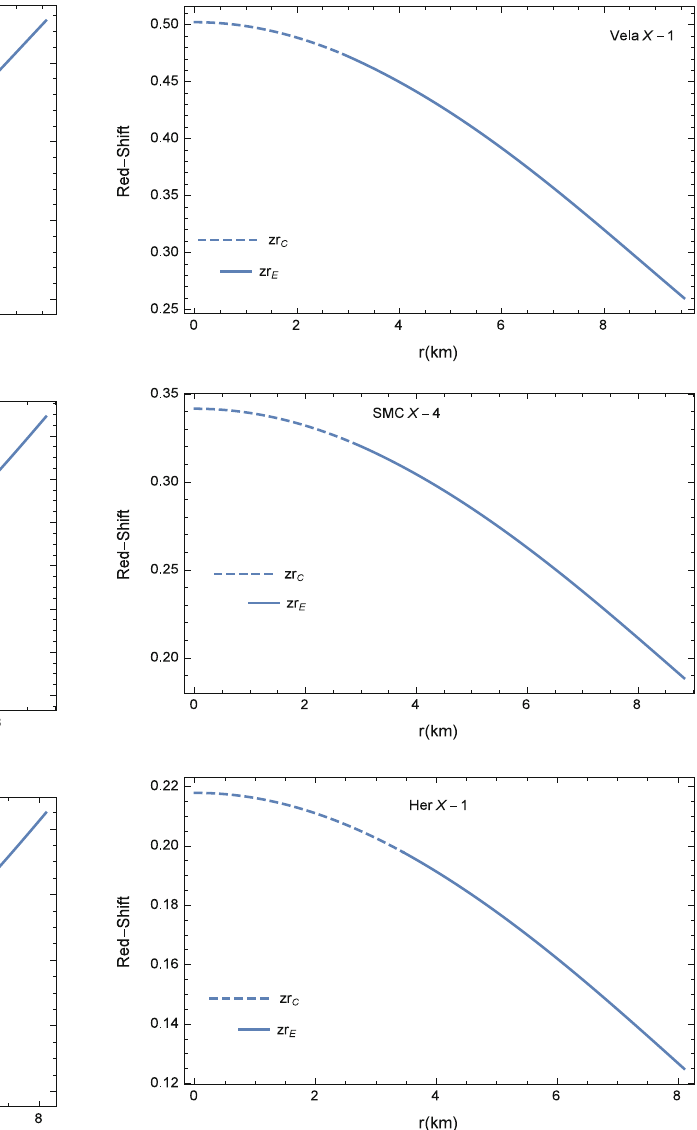
Fig. 5 Variation of mass with radial coordinate r for (i) the neutron star in Vela X-1(upper) (ii) SMC X-4 (middle) (iii) Her X-1